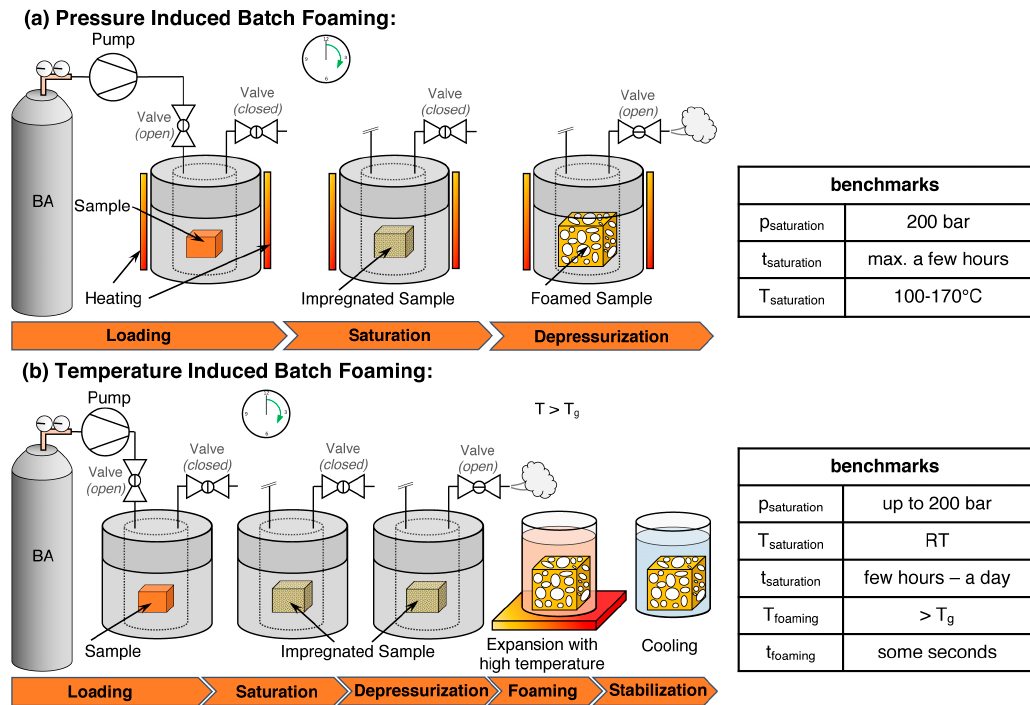
Figure 2. Principles of ( a ) pressure-induced batch foaming (at the top), and ( b ) temperature-induced batch foaming (at the bottom). For orientation, some benchmark parameters are given (note: for more detailed experimental set-up and parameters, please consult the literature).